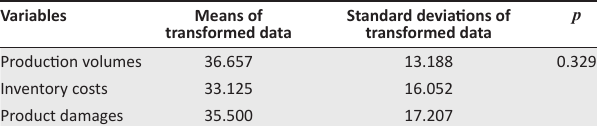
FIGURE 2: Box plots determining the normality and homogeneity of variances.